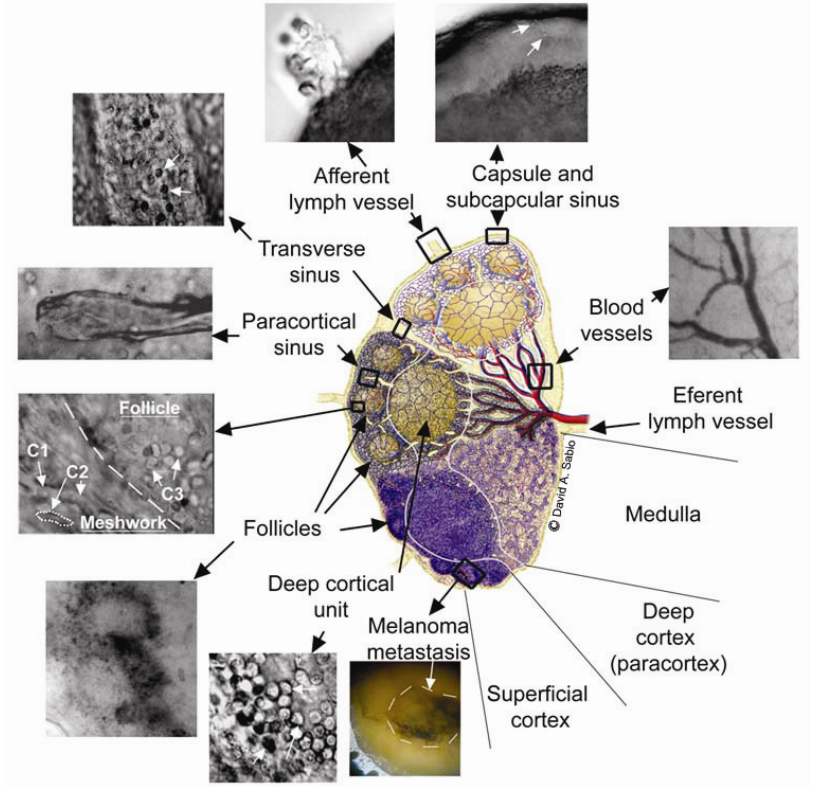
Figure 6. Optical imaging of the microanatomy of a fresh lymph node ex vivo obtained with optical clearance using 80% glycerol. The central schematic shows a midsagittal section of a lymph node containing three lymphoid lobules with the basic anatomical and functional unit of the lymph node. Top and middle lobules: microanatomical schematics of lobular compartments (superficial cortex, deep cortex, and medulla) without (top) and with (middle) reticular meshwork. Bottom lobule: a lobule of a mouse lymph node as it appears in conventional histological section. C1 shows basophilic lymphocytes; C2 shows elongated fibroblastic reticular cells; and C3 shows B lymphocytes and follicular dendritic cells [83].